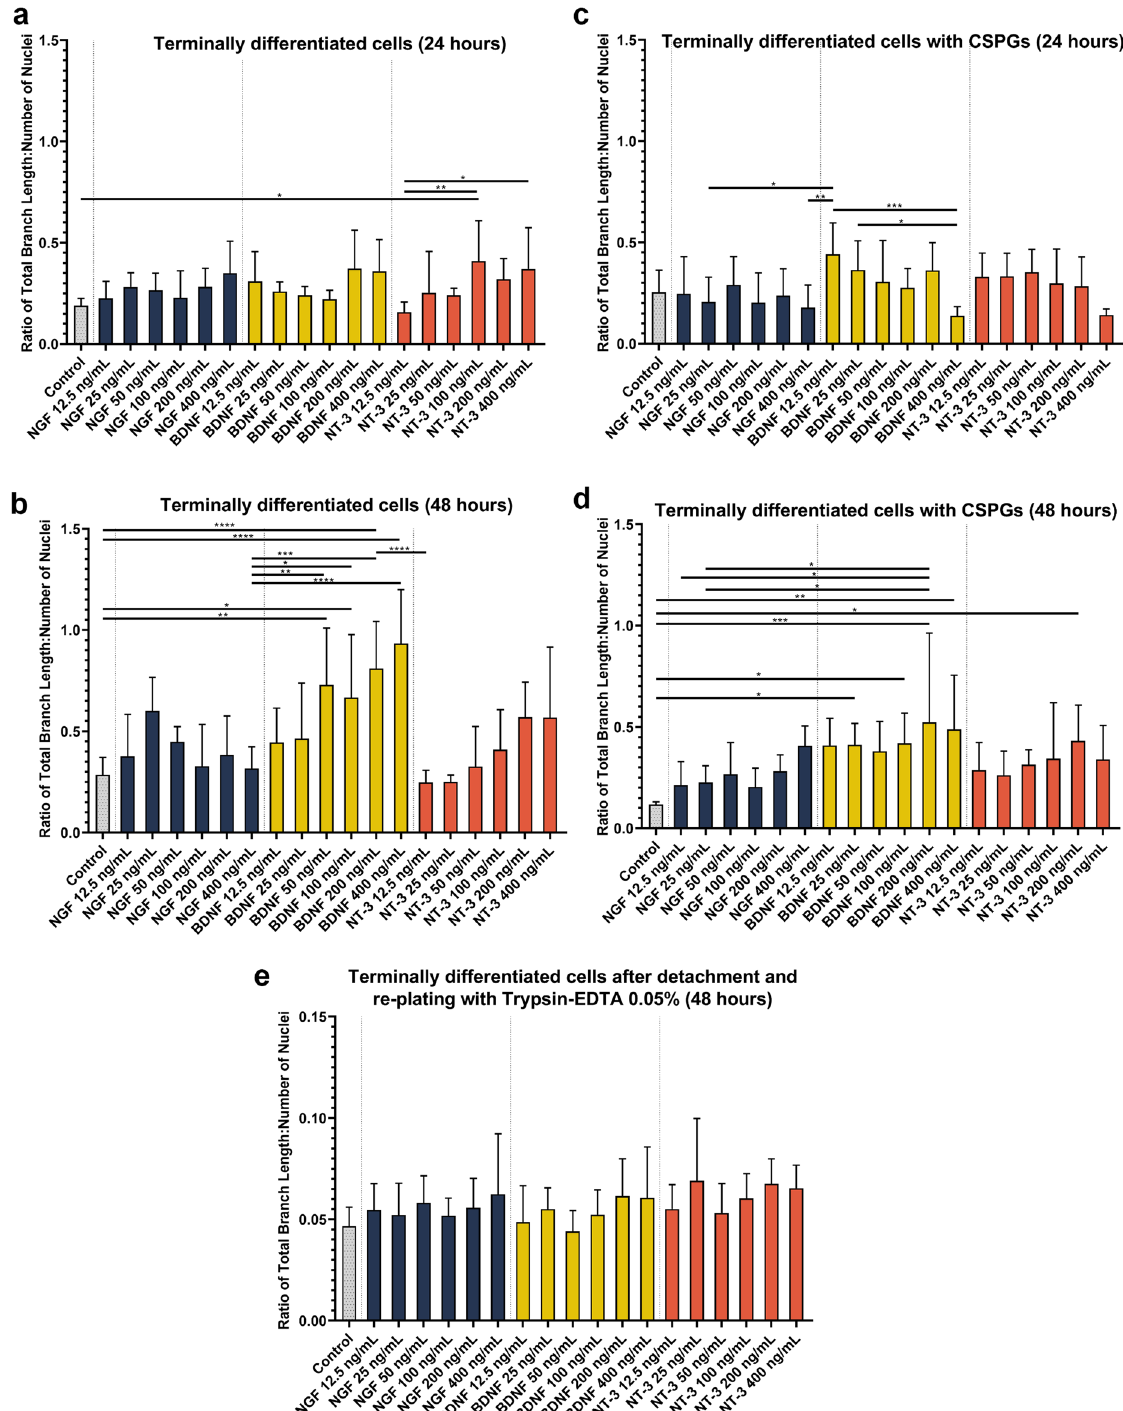
Figure 6. Neurite outgrowth quantification in response to treatment with NGF, BDNF or NT-3. ( a ) Terminally differentiated cells incubated with neurotrophin medium for 24 h and ( b ) Terminally differentiated cells incubated with neurotrophin medium for 48 h. ( c ) Terminally differentiated cells incubated with neurotrophin medium and 10 µg/mL CSPG for 24 h. ( d ) Terminally differentiated cells incubated with neurotrophin medium and 10 µg/mL CSPG for 48 h. ( e ) Terminally differentiated cells re-plated with trypsin–EDTA (0.05%) and incubated with neurotrophin medium and 10 µg/mL CSPG for 48 h. Each bar represents the mean ± SD. A one-way ANOVA test and Tukey’s post-hoc analysis was performed to evaluate statistical significance where **** p < 0.0001, *** p < 0.001, ** p < 0.01 and * p <